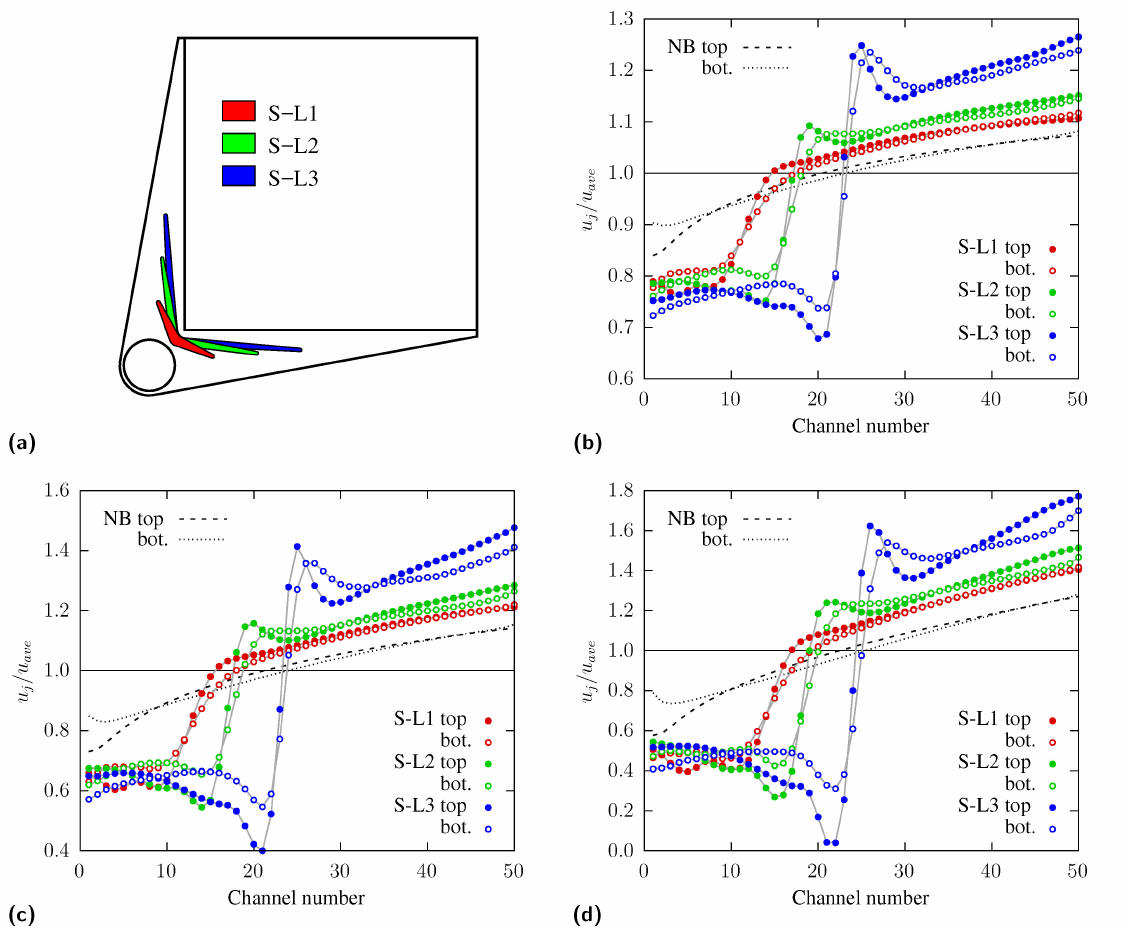
Figure 6. Header with solid baffle: ( a ) sketch of the inlet header with baffles of different lengths; normalized velocity distributions for top and bottom layers obtained with different average velocities: